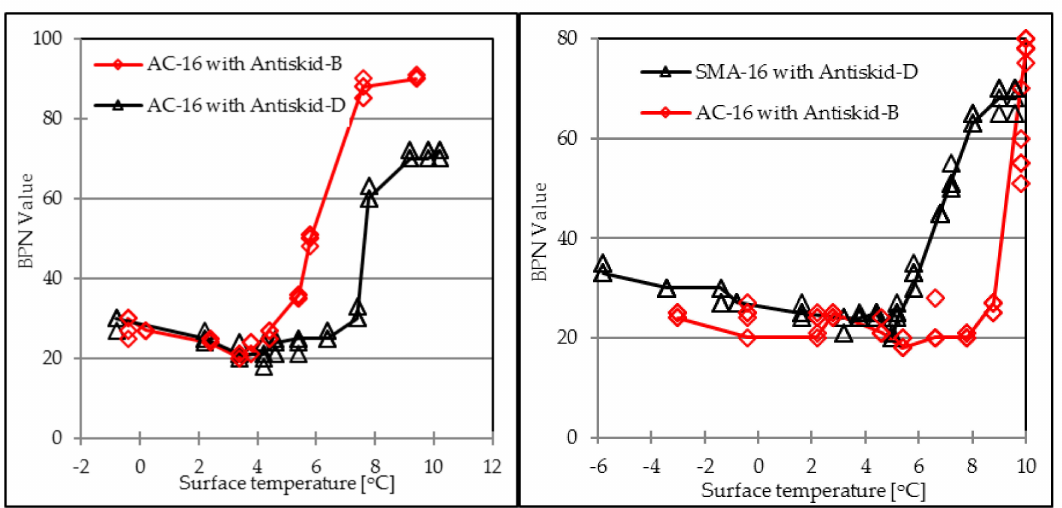
Figure 6. Ice e ff ect on the BPN values.